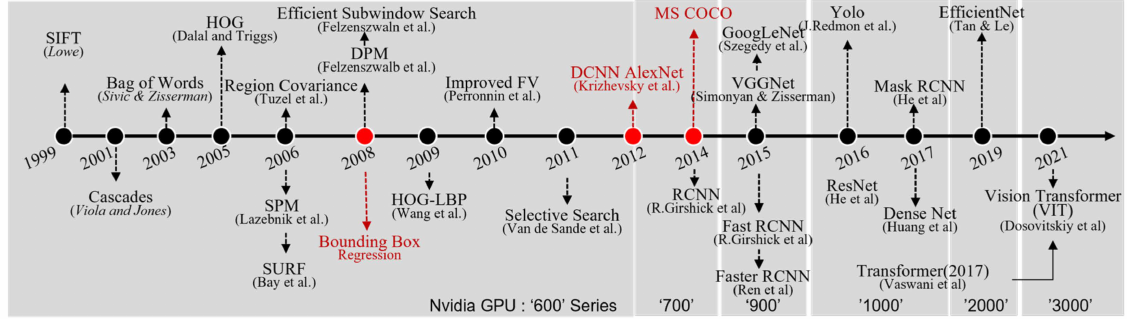
Figure 2. Milestones of object detection techniques and the evolution of hardware (GPU).